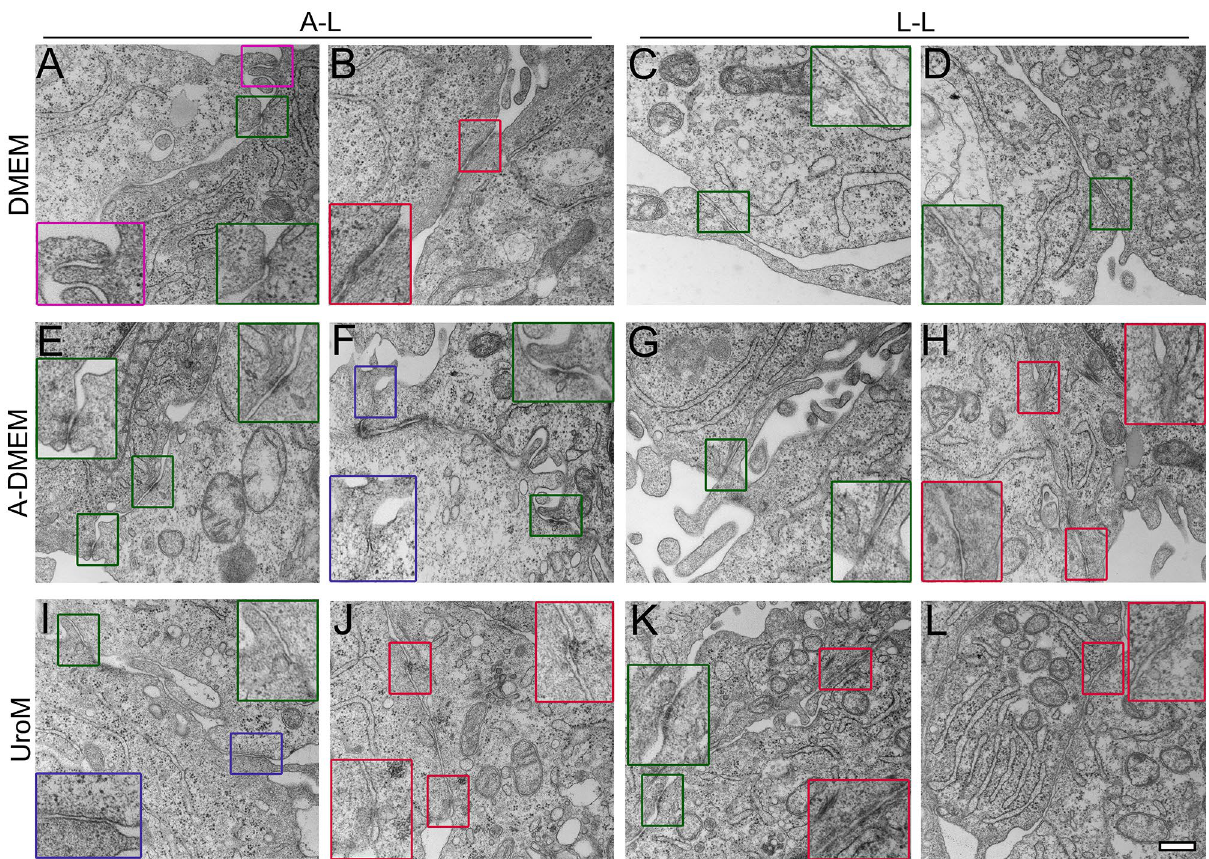
Figure 6. Ultrastructure of FLO-1 cells cultured on porous membranes and maintained in DMEM, A-DMEM and UroM for 4 wks at the A–L and L–L interfaces, analyzed with high magnification TEM. Cells are connected by protrusions (purple inset, A ), anchoring junctions (green insets, A , C , D , E – G , I , K ), adherent junctions and desmosomes (red insets, B , H , J – L ). Cells maintained in A-DMEM and UroM are occasionally connected also via immature tight junctions (blue insets, F , I ). Large insets framed with green/red/purple/blue lines are 100% enlarged images of corresponding small green/red/purple/blue framed insets. Scale bar, 400